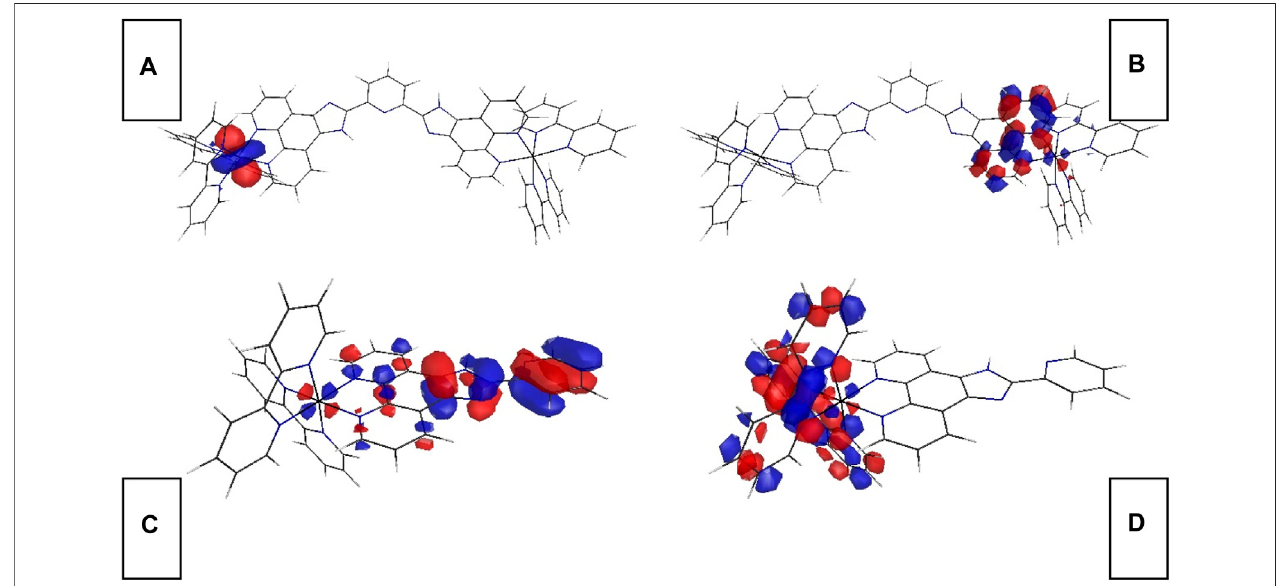
FIGURE 2 | Graphical presentation for Ru-n FMOs. (A) Ru-1 HOMO, (B) Ru-1 LUMO, (C) Ru-3 HOMO, and (D) Ru-3 LUMO.